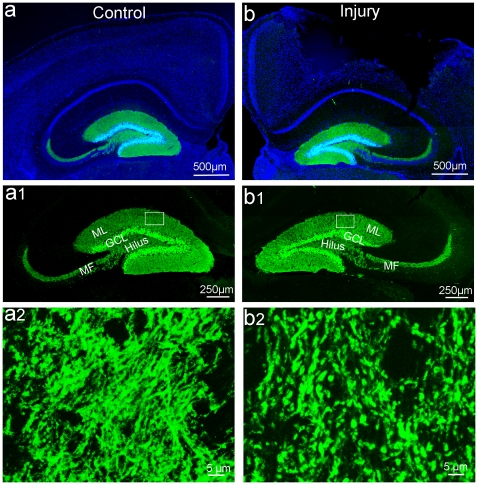
The anatomical structure of the hippocampus in POMC-Cre;Z/EG double transgenic mice.There was no gross morphological change in the HDG between moderate TBI (a, a1) and sham control mice (b, b1). EGFP staining (green) showed that there were many more disconnected bulbs and swellings in the injured HDG (b2) compared with the sham (a2).